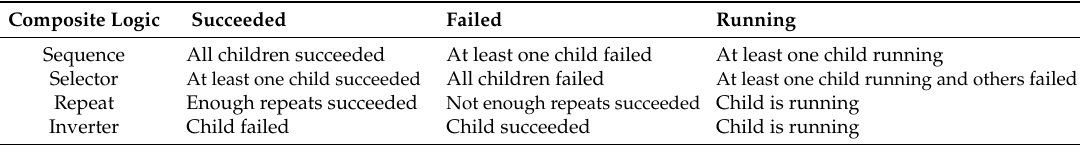
Table 3. Sample of behavior